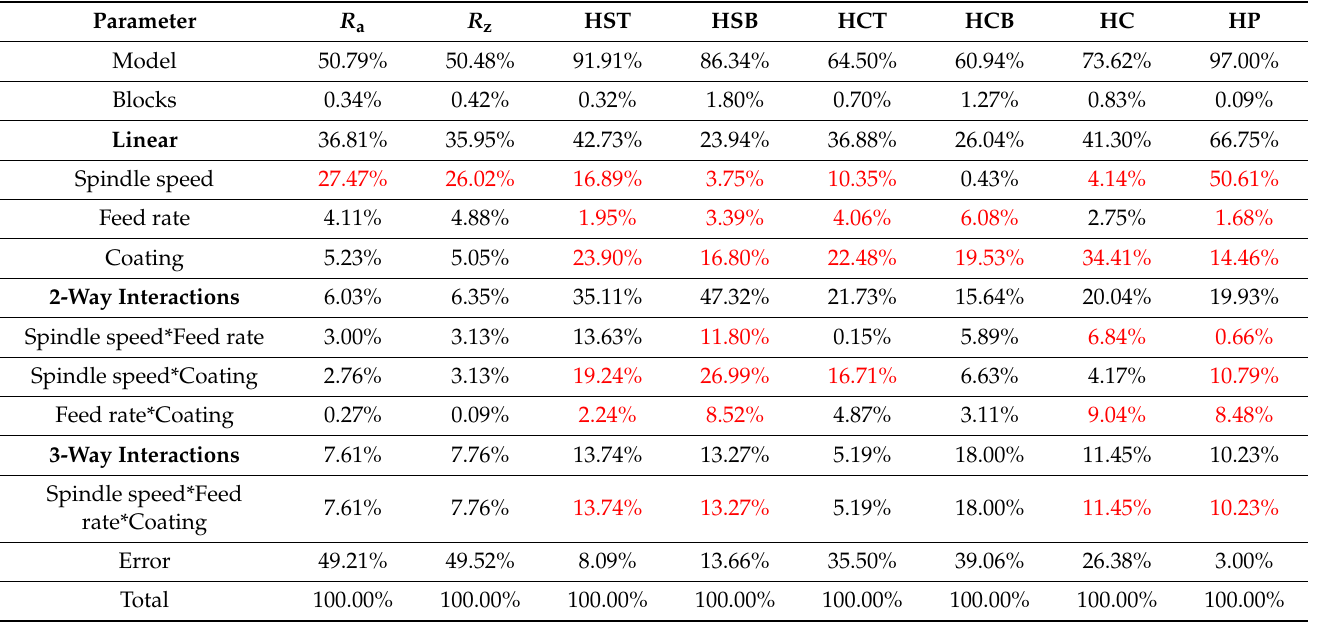
Table 5. ANOVA analysis to show the percentage contribution of spindle speed, feed rate, and coating type for the cutting tool on the investigated hole-quality